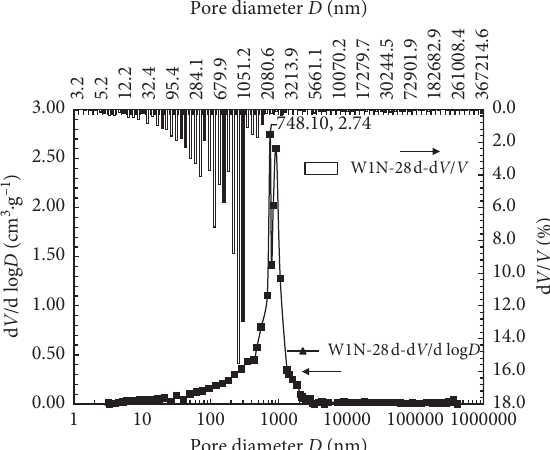
Figure 13: Pore diameter distribution of 28-day-old W1 N con- cretion by MIP test.